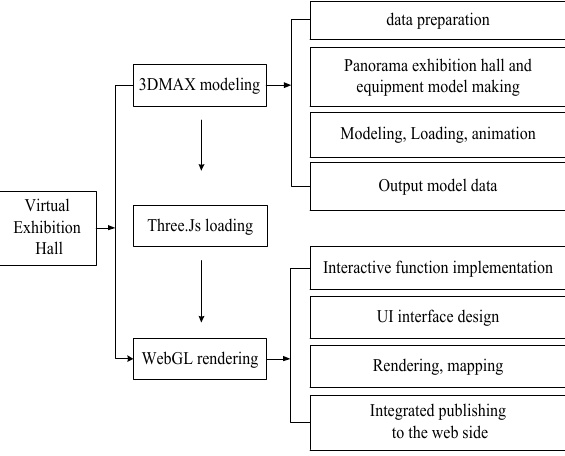
Figure 5. Virtual showroom development